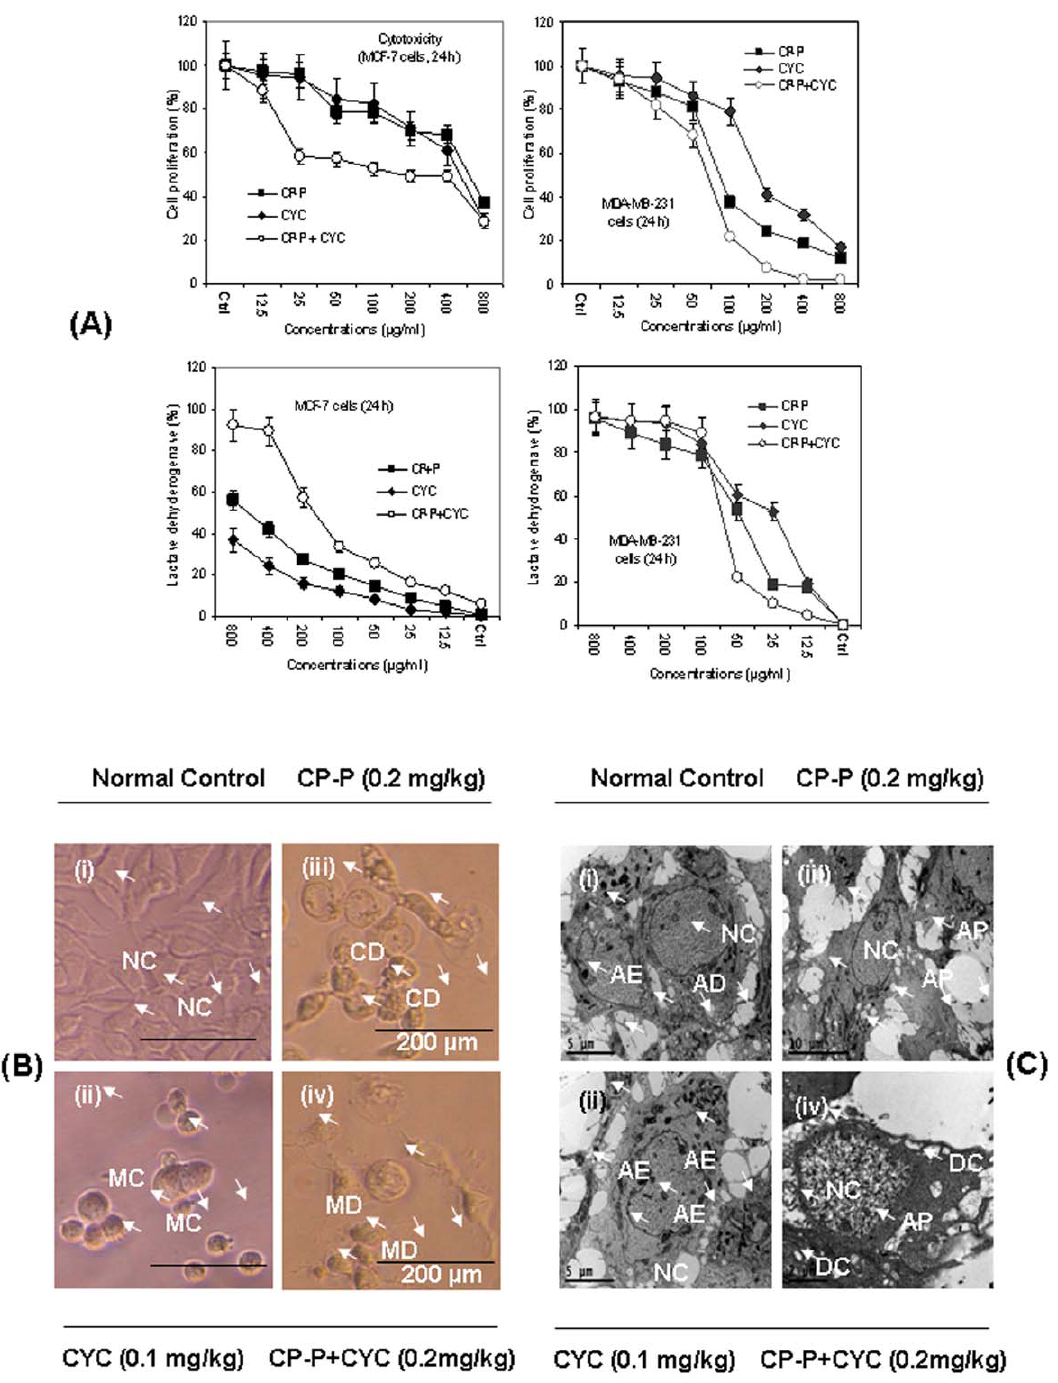
Figure 2. The antiproliferative effect of CP-P evaluated against MCF-7 and MDA-MB-231 human breast cancer cells. (A) In vitro cytotoxicity of CP-P, with or without CYC, upon MCF-7 and MDA-MB-231 cells at different doses (800–12.5 m g/ml). The CP-P alone, or when combined with CYC, leads to significant (*P , 0.01) reduction in cell proliferation even at 12.5 and 50 m g/ml doses versus untreated control. The MCF-7 cells were more sensitive against the combination treatment. Values are mean 6 SD of three replicates. Untreated MCF-7 cells served as a control, CP-P treatment evidenced cell death (CD) at 100 m g/ml concentrations on MDA-MB-231 cells. The CP-P alone, or in combination with CYC, caused the most significant (*P , 0.01) leakage of LDH. The combination treatment induced more cell-death and lytic effects in both cell lines than CP-P or CYC alone. (B) Light micrographs showing the MCF-7 cell morphology before and after treatment. (i) There was no effect on untreated MCF-7 cells as a control, (ii) protein (CP-P) or drug (CYC) alone treated cells induced severe cell membrane damage and inhibited MCF-7 cell growth, (iv) We also observed that MCF-7 cells treated with CP-P in combination with CYC showed remarkable morphological changes like cell shrinkage, formation of membrane blebs, nuclear and cytoplasmic condensation when observed under microscope (Symbol denotes: NC-Normal Control, MC-morphological changes, CD-Cell Death, MD - membrane damage). (C) Electron micrographs of MCF-7 cells exposed to CP-P alone, or with CYC, showing the cellular and morphological changes. The transmission electron microscopy (TEM) analysis was performed on MCF-7 human breast cancer cells exposed to the CP-